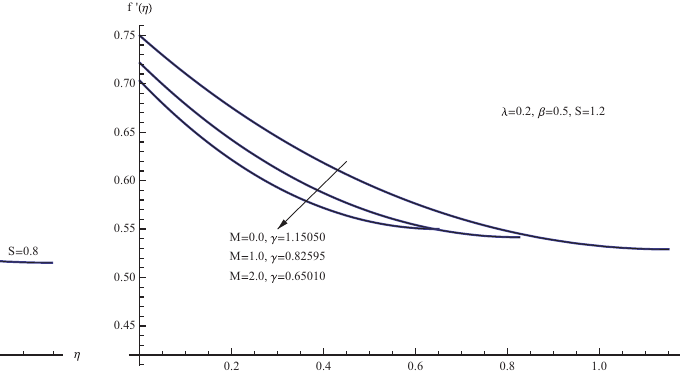
Figure 4: ( ) ϕ η for assorted quantities of S .